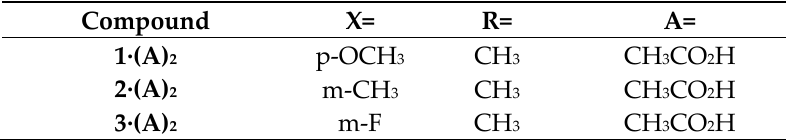
Table 1. Ligands of the rhodium compounds 1 ∙ (A) 2 – 3 ∙ (A) 2 .